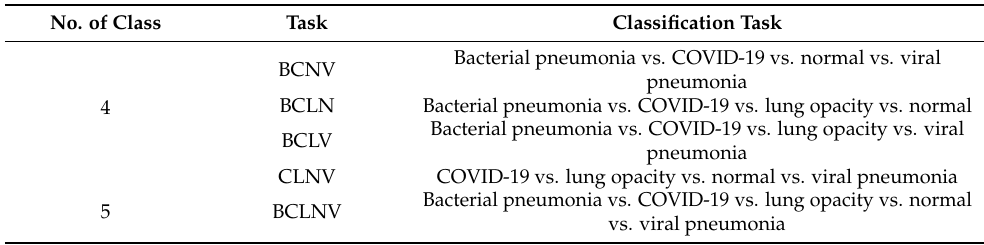
Table 3. Considered classification tasks in this